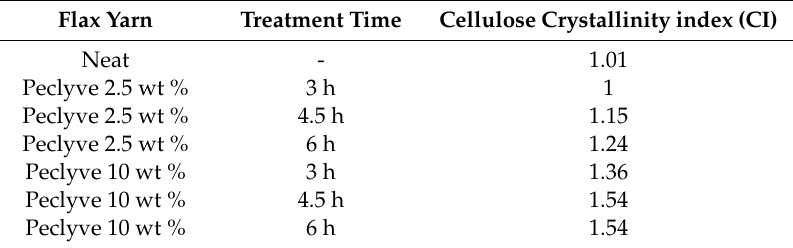
Table 3. The crystallinity index of cellulose for the neat and enzymatically modified flax yarns using di ff erent times and Peclyve